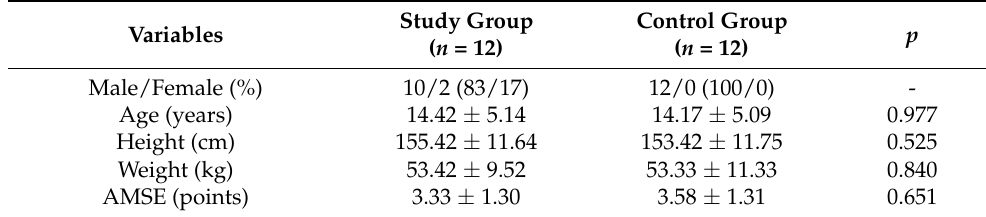
Table 1. Participants’ demographic